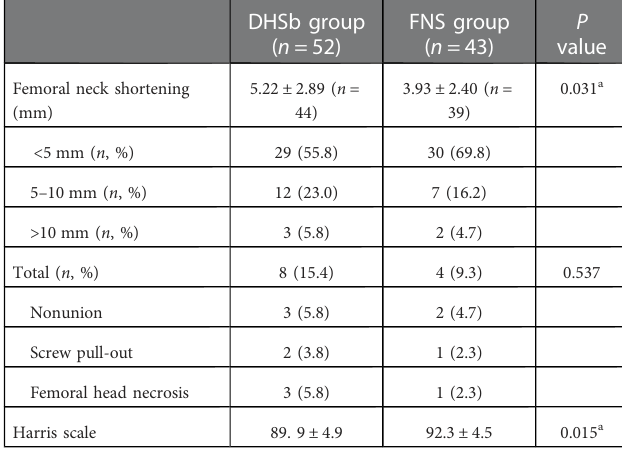
TABLE 3 Postoperative complications and Harris scale score for both